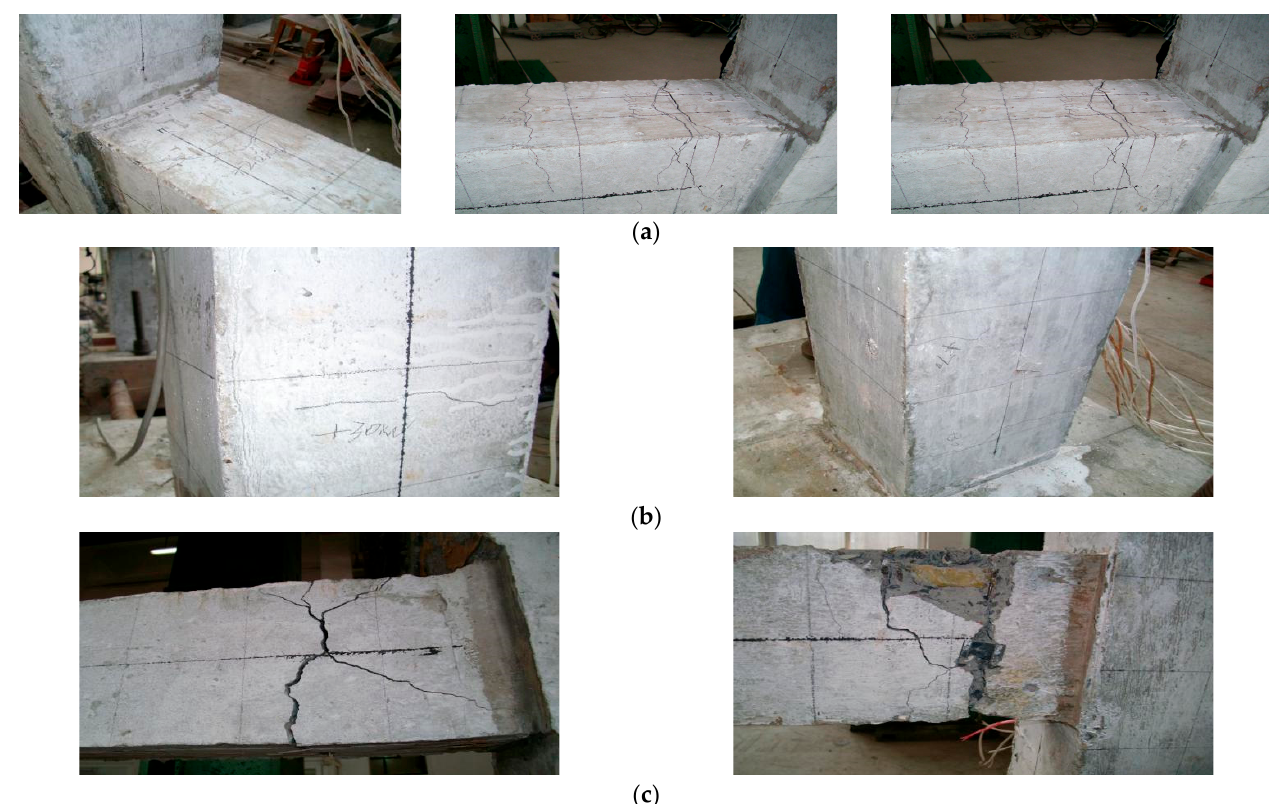
Figure 10. Experimental phenomenon diagram of KJ-2. ( a ) Cracks in the beams of KJ-2. ( b ) Cracks in the bottom of columns of KJ-2. ( c ) Failure modes of KJ-2.